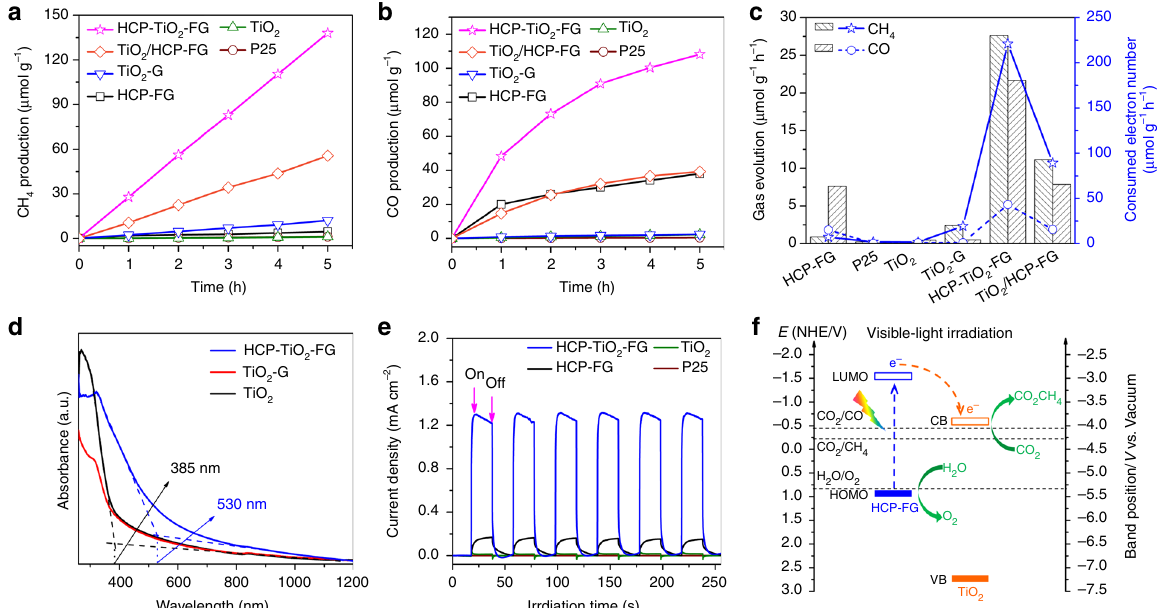
Fig. 4 The photocatalytic performance of CO 2 reduction, optical and photoelectrical properties, and mechanism of charge transfer pathway. Time- dependent production of a CH 4 and b CO in photocatalytic CO 2 reduction with different catalysts under visible-light ( λ ≥ 420 nm). The photocatalytic reactions were carried out in a batch system under standard atmospheric pressure. The partial pressure of CO 2 and H 2 O were constant with the water contents below the scaffold loading photocatalyst. Under visible-light irradiation, the temperature of the water was measured to be about 50 °C. c Average ef fi ciency of photocatalytic CO 2 conversion with different catalysts during 5 h of visible-light ( λ ≥ 420 nm) irradiation. d UV-Vis absorption spectra of TiO 2 , TiO 2 -G, and HCP-TiO 2 -FG catalysts. e Amperometric I − t curves of samples under visible-light ( λ ≥ 420 nm) irradiation. f Proposed mechanism of charge